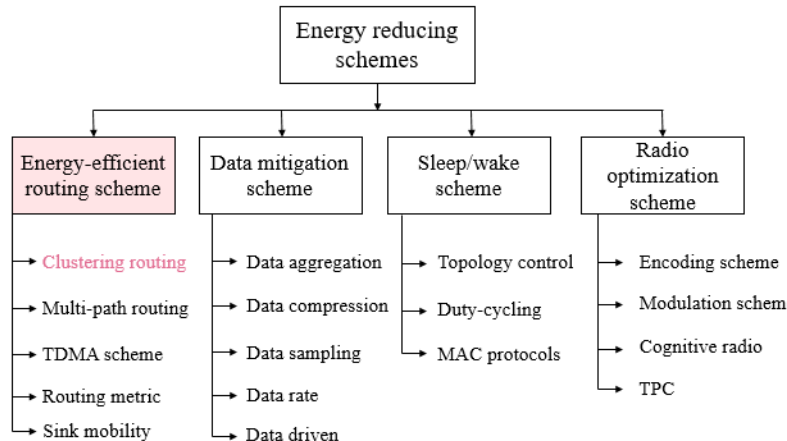
Figure 1. Classification of energy reducing schemes in WSNs.